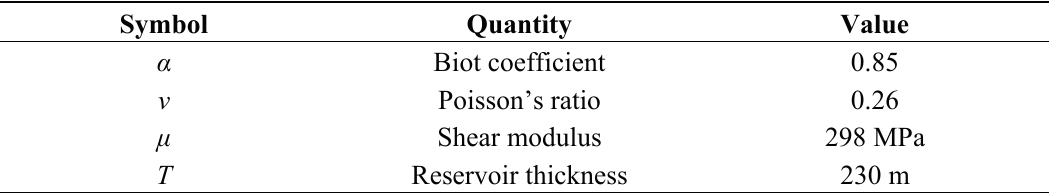
Table 1. Parameters used in model calculation. The shear modulus for a Poisson’s ratio